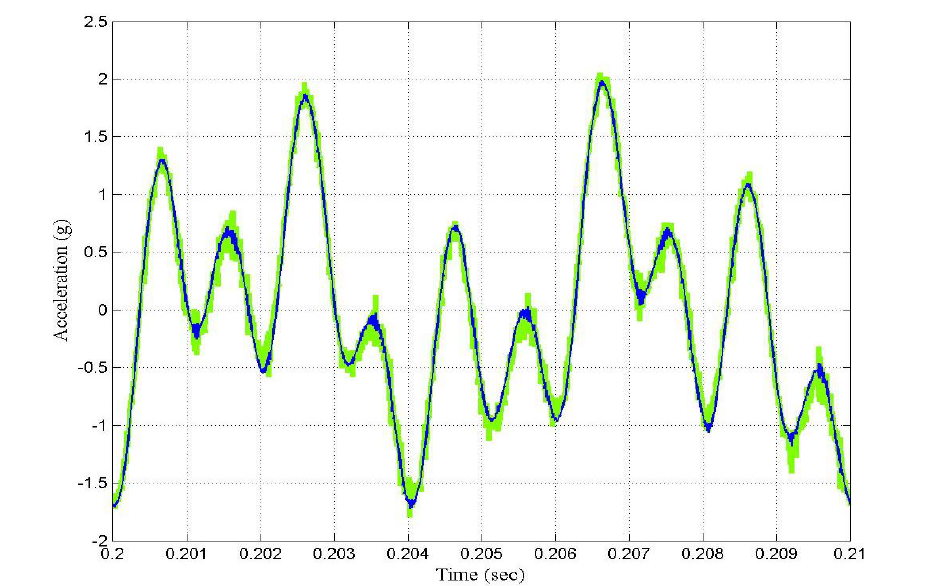
Figure 10. Time waveforms of the output signal for the case under test: Green—output signal before filtering; Blue—output signal after filtering by using the fast LMS adaptive